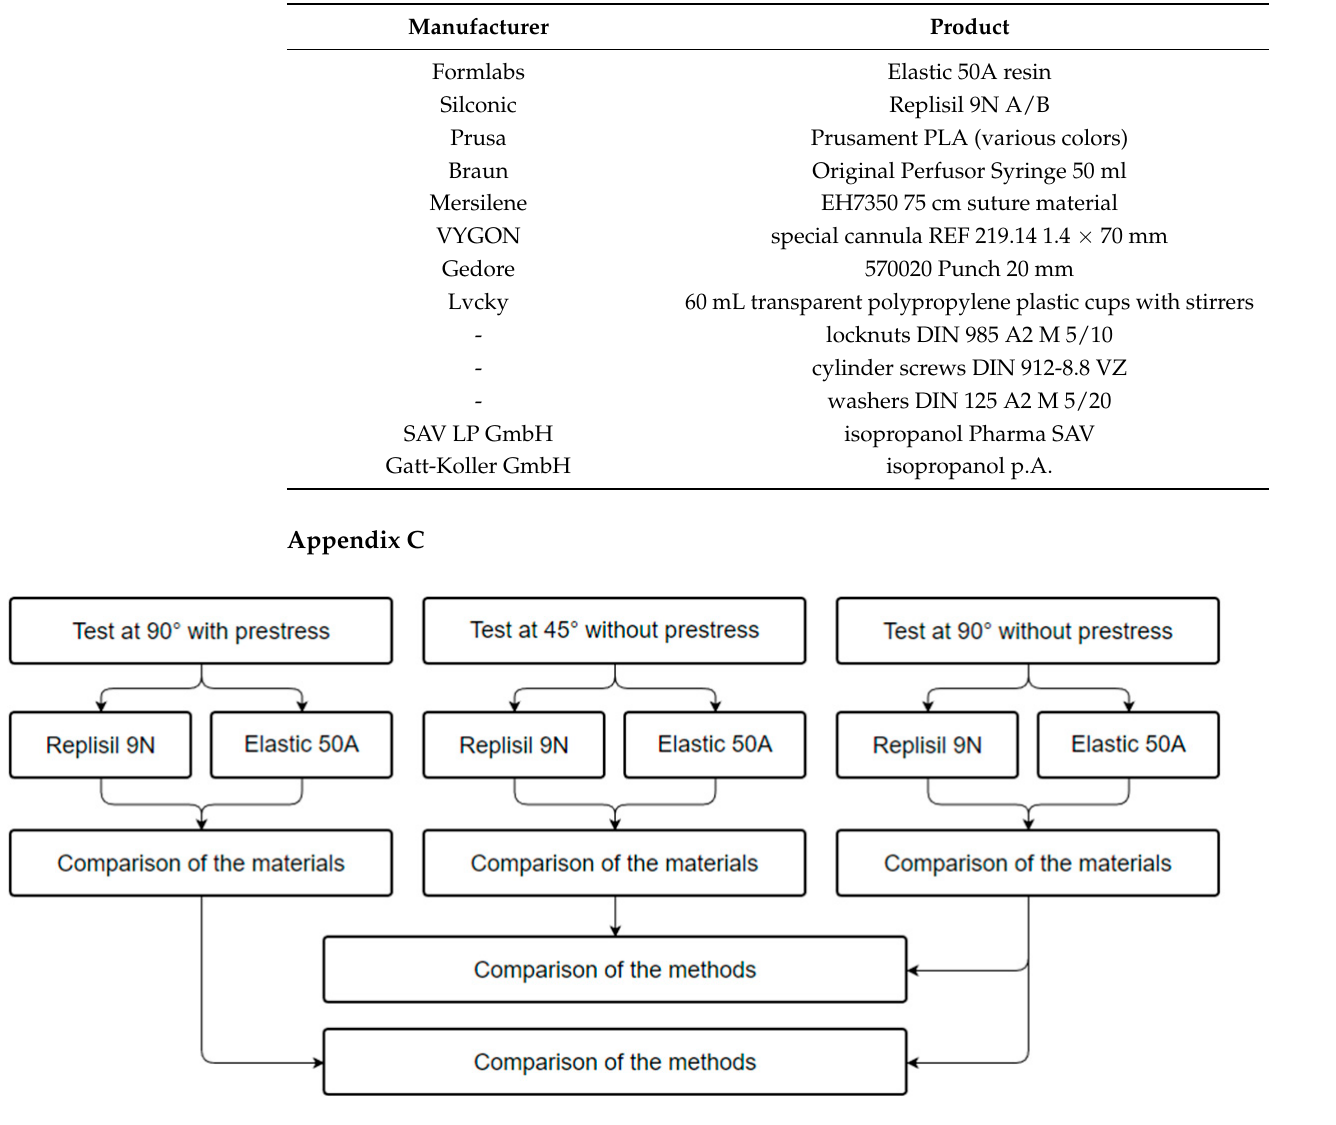
Table A2. List of the used materials.